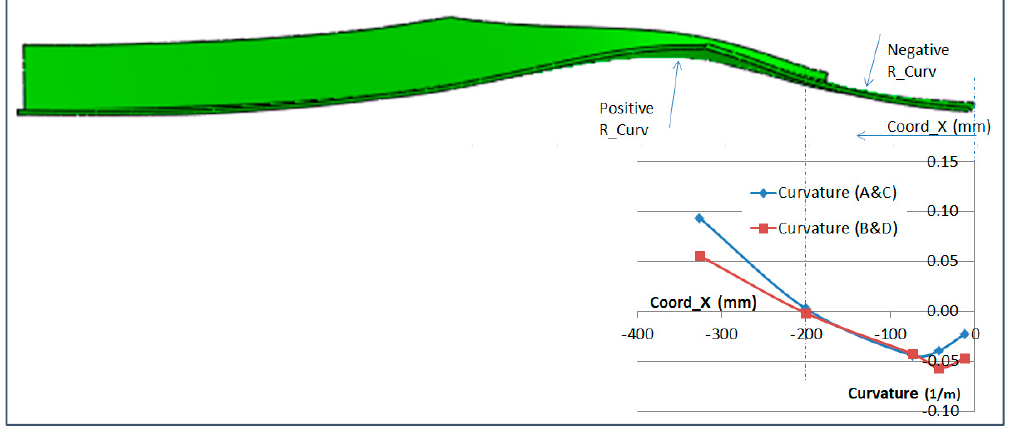
Figure 26. Predicted Specimen Deflection vs. OF Sensor Curvature.